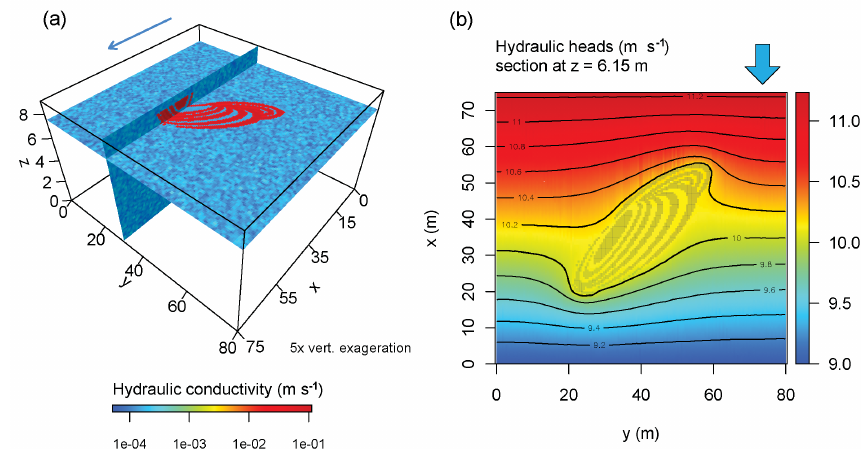
Figure 5. (a) Hydrogeological model set-up with spatial distribution of the hydraulic conductivity values. (b) Hydraulic head at the upper model boundary (top view, contour every 0.2m). The blue arrows indicate the main flow